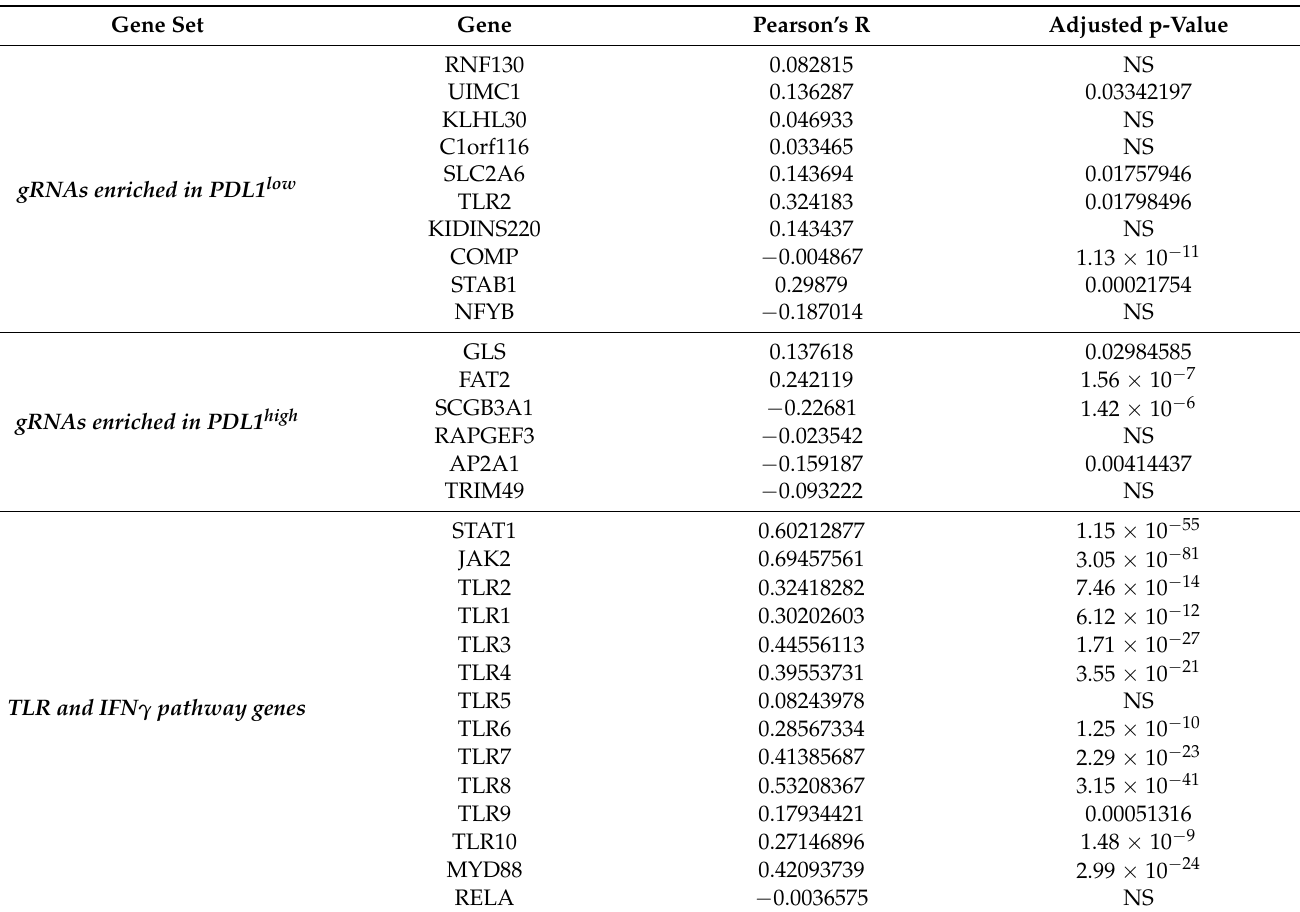
Table 3. Log 2 (RSEM+1) values from TCGA Head and Neck Cancer cohort ( n = 566) were retrieved from the UCSC cancer genomics browser